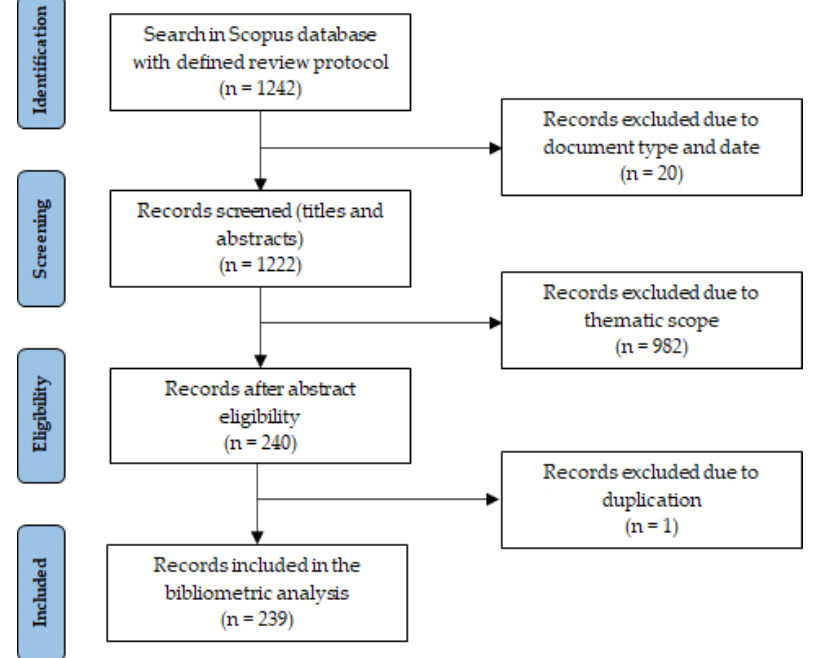
Figure 1. Data collection flow diagram.